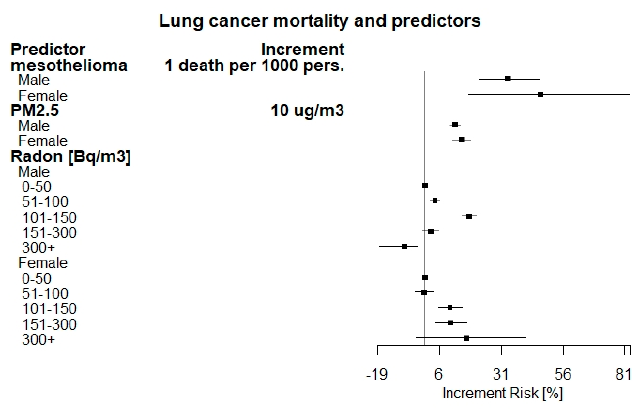
Figure 1. Forest plot of adjusted increment risk of lung cancer mortality by predictors. Table 4. Estimates of adjusted * Increment Risk (%) (approximate 95% CI) of lung cancer (LC) mortality, expected LC cases and attributable LC fraction by predictor, 2006–2015.